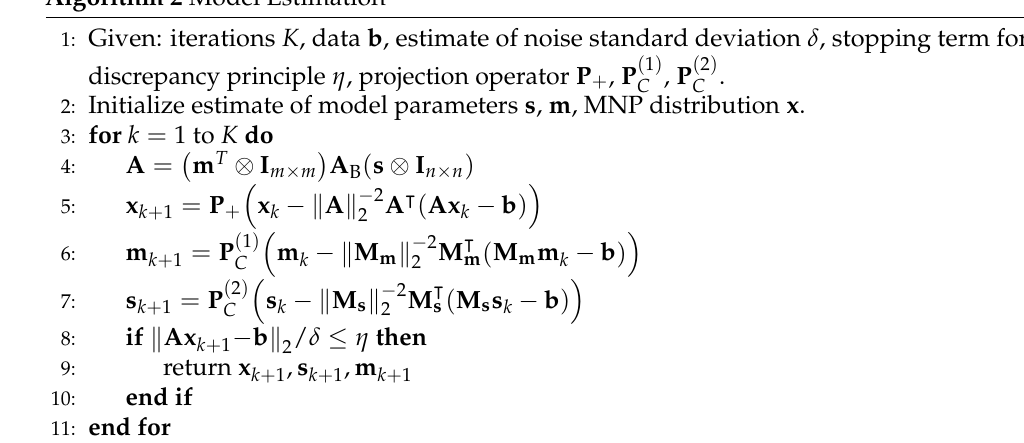
Figure 4. The matrix consisting of all quadratic forms shows the correlation between different magnetic field components for different moment directions. We see that most of the field components are orthogonal to each other, while there are some off-diagonal elements, meaning that there exists a correlation between the corresponding fields. However, they are still linearly independent. Algorithm 2 Model